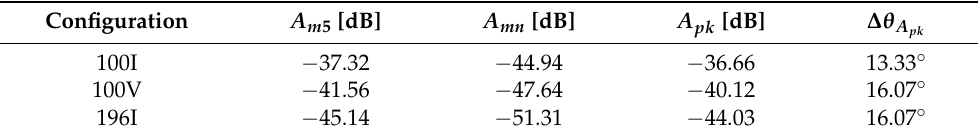
Table 2. Summary of the beampattern parameters for the best solutions at each configuration. Coarray-based fitness